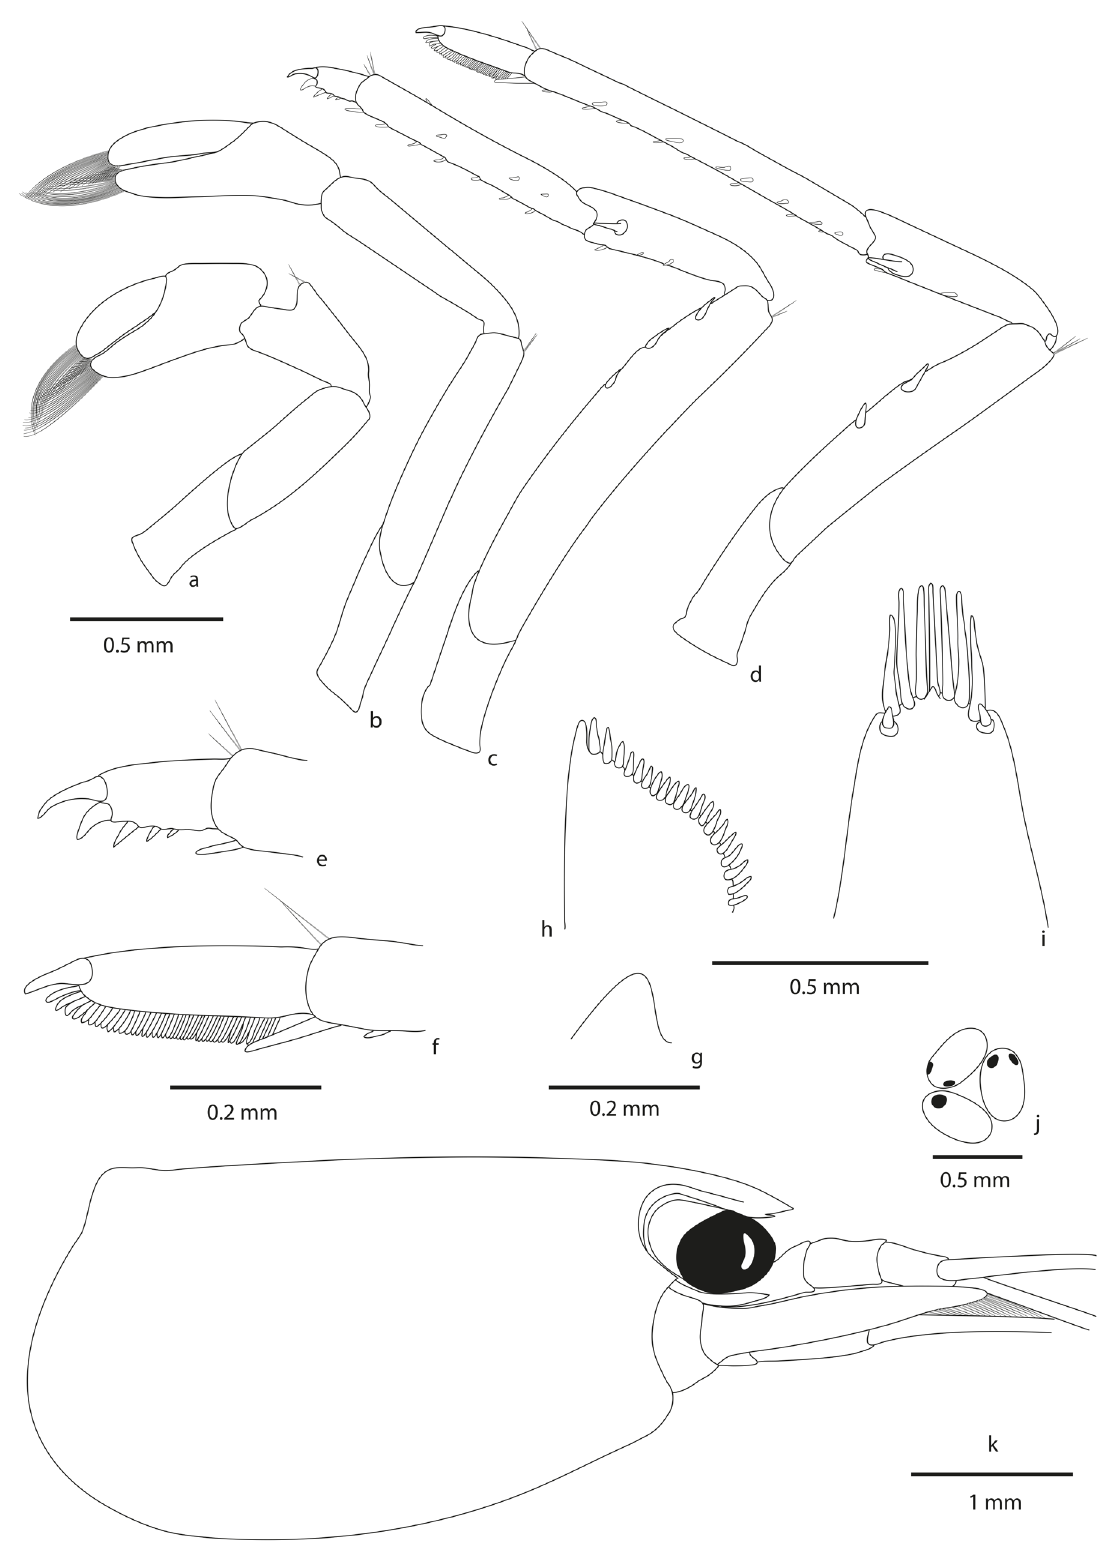
Fig. 21. Caridina poarae sp. nov. a . First pereiopod. b . Second pereiopod. c . Third pereiopod. d . Fifth pereiopod. e . Dactylus of third pereiopod. f . Dactylus of fifth pereiopod. g . Pre-anal carina. h . Uropodal diaeresis. i . Telson. j . Eggs. k . Cephalothorax. MNHN-IU-2018-2922